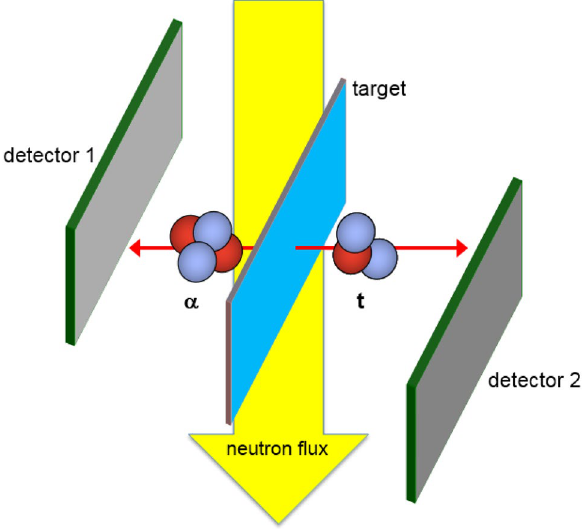
Figure 6. Experimental concept for the position sensitive lithium detection with the 6 Li(n, α) 3 H-reaction. Both 20 × 20 mm 2 large silicon detectors have resistive layers for charge splitting on both surfaces. Two readout strips at the edges in horizontal and vertical direction respectively allow for a position resolution of σ x,y ~ 0.2 mm for a typical particle energy of 2 MeV.